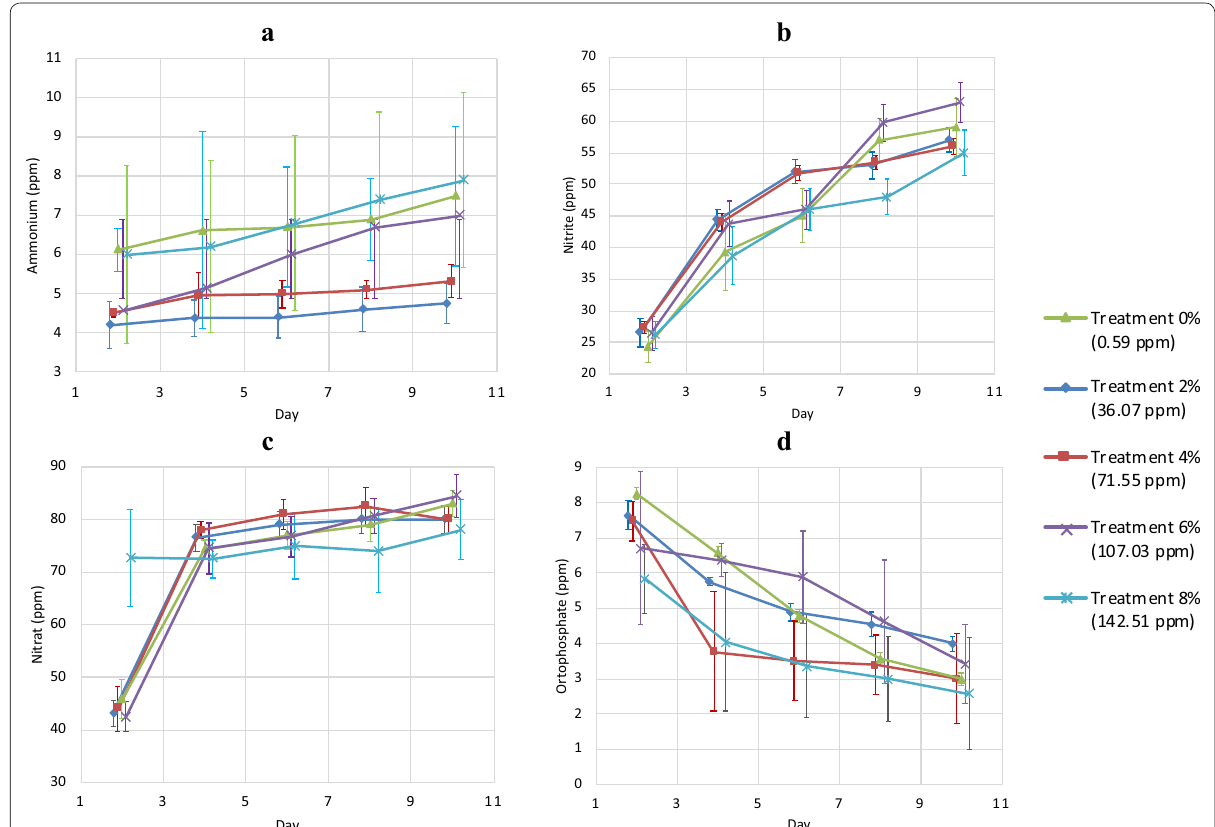
Fig. 4 Five treatments of CO 2 concentration during aeration fluid consisting of 0.59, 36.07, 71.55, 107.03 and 142.51 ppm for concentration curves of (a) ammonium, (b) nitrite, (c) nitrate, (d) orthophosphate in the culture of Nannochloropsis